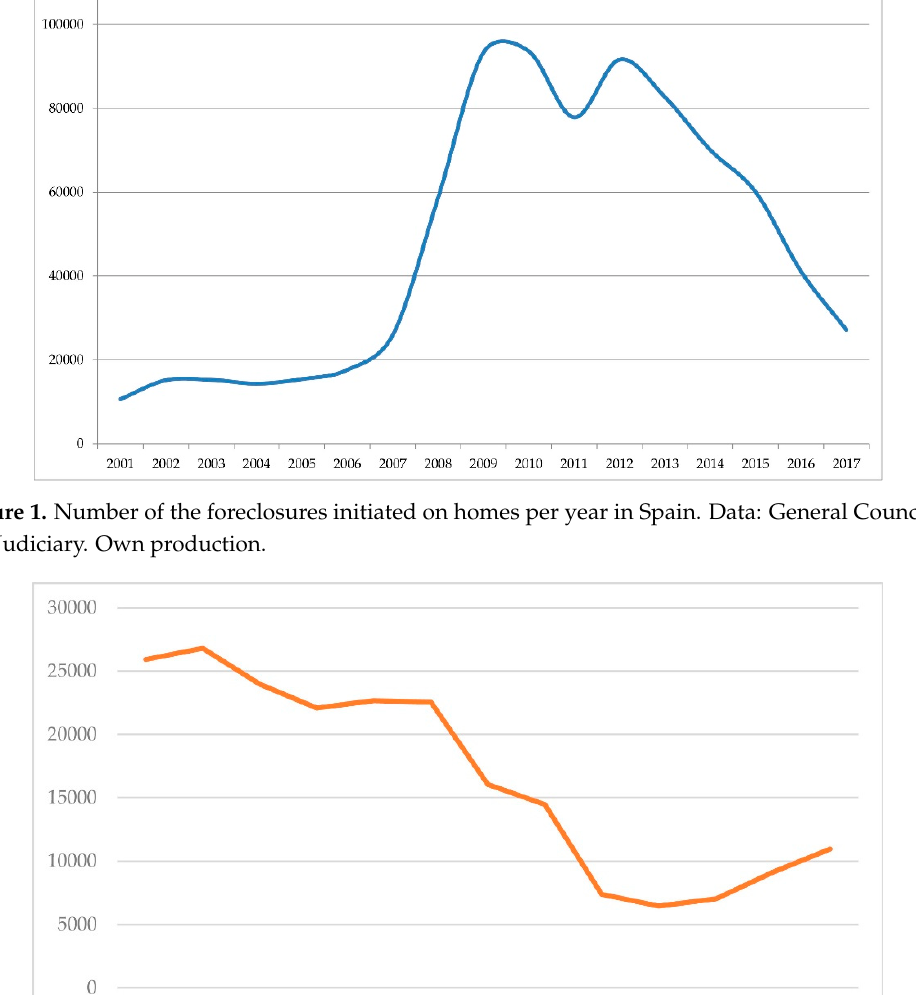
Figure 2. Number of evictions due to non-payment of rental or deposits per year in Spain. Data: General Council of the Judiciary and INE. Own production.